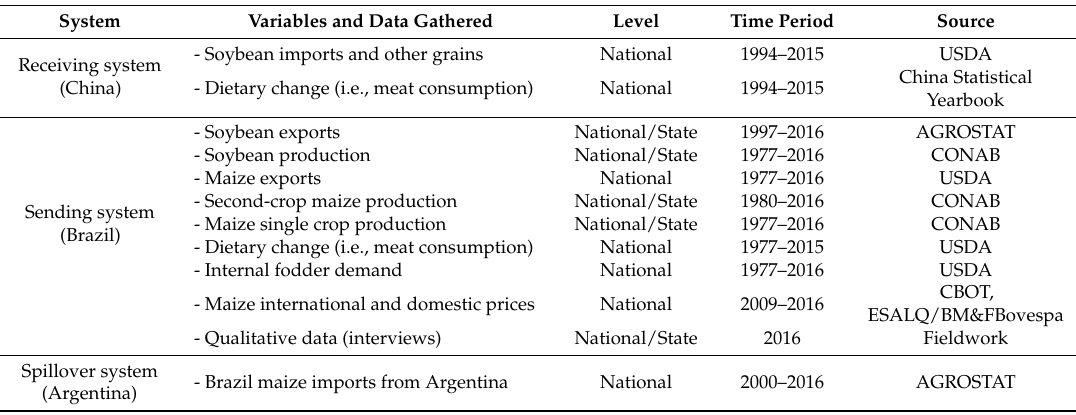
Table 2. Data used in this